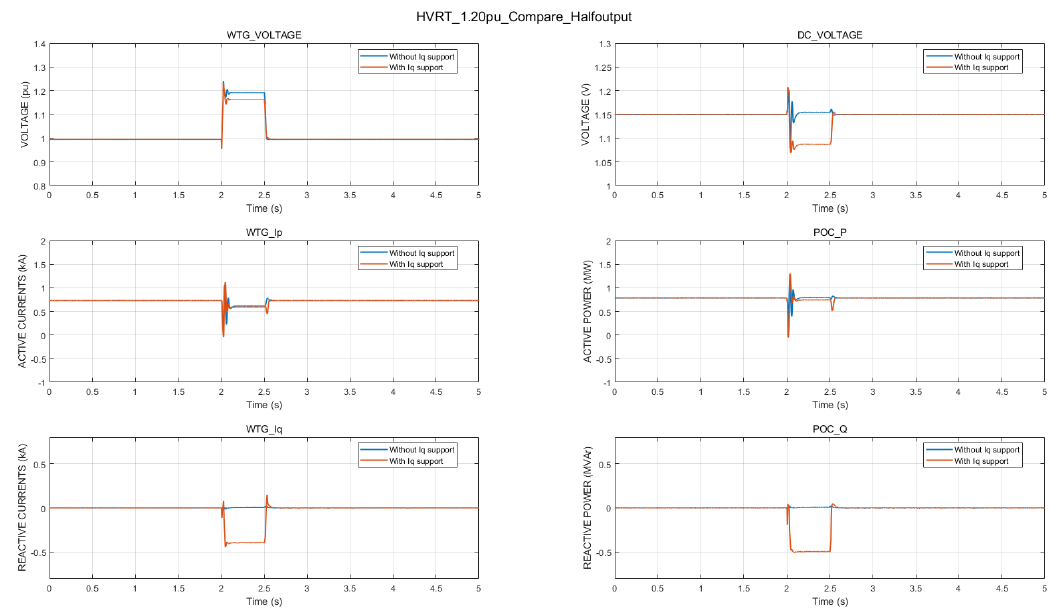
Figure 14. Comparison study of a 1.20 pu HVRT incident with half active power output.